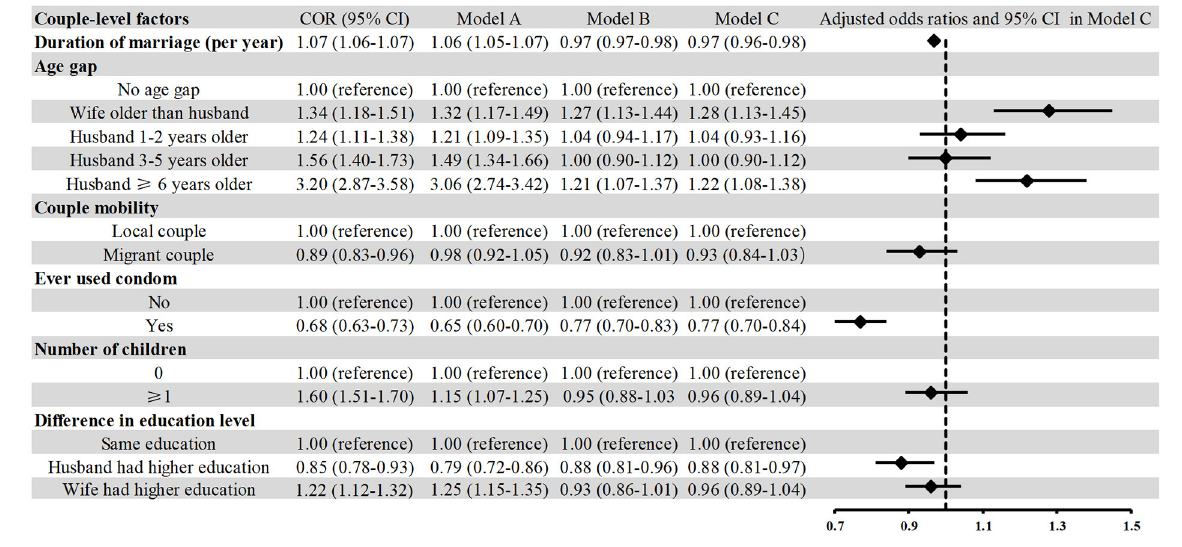
FIGURE3 Association between couple-level factors and syphilis infection among men who participated in the National Free Preconception Health Examination Project in Guangdong Province, China during 2014–2019 ( N = 1,755,156). Model A included only couple-level factors; Model B additionally adjusted for year of screening, age, ethnicity, educational level, household registration, smoking, drinking, migrant, illicit drug use, and previous STIs. Model C additionally adjusted for region.